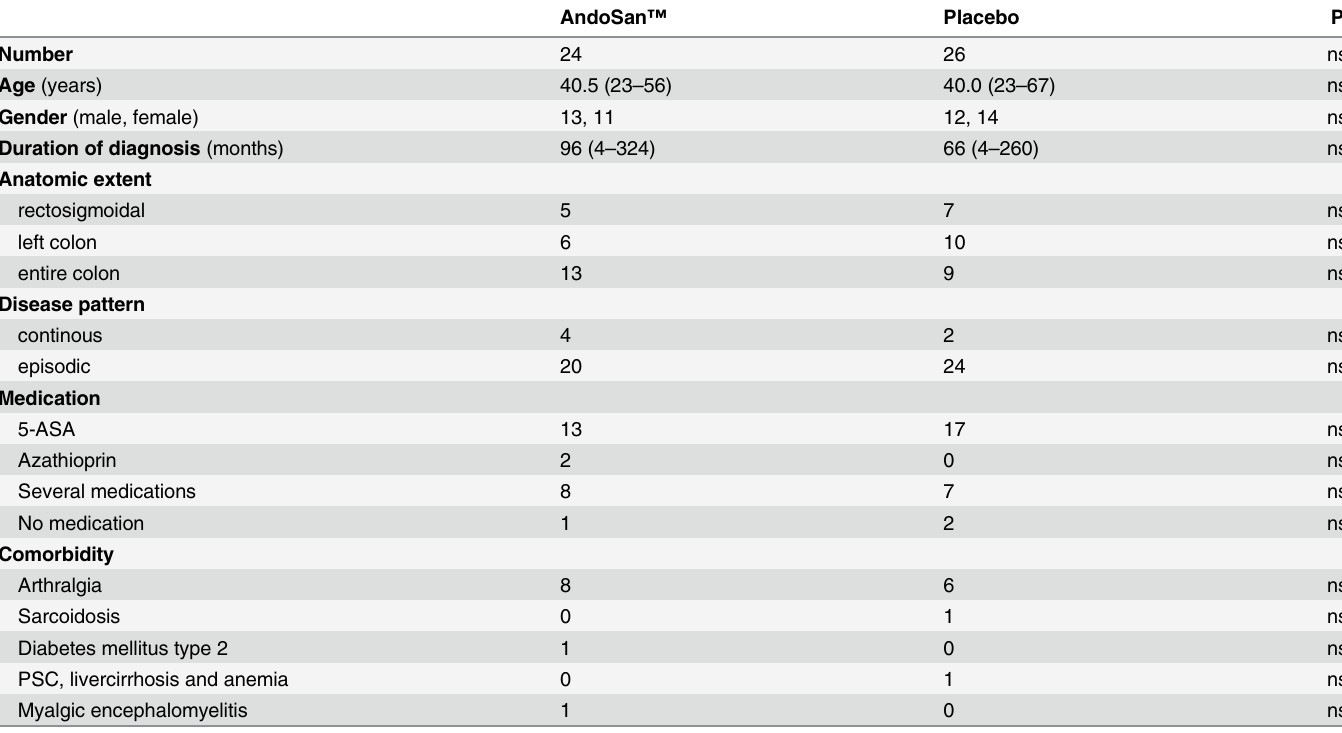
Table 1. Demographic and patient